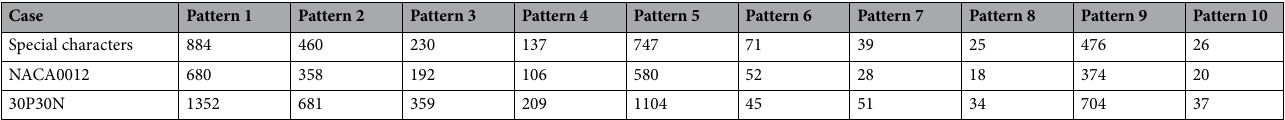
Table 3. The statistics of the number of various patterns in the grid generation